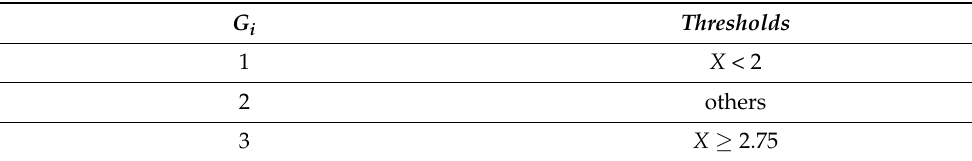
Table 5. Thresholds for combined grade G i .